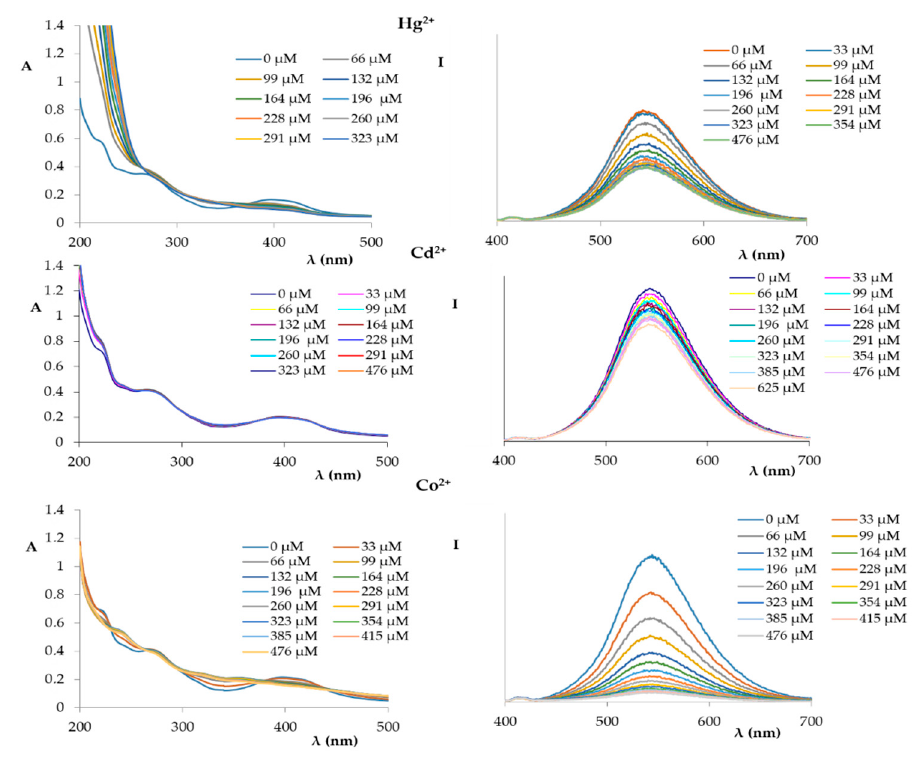
Figure 4. UV spectra ( left ) and fluorescence spectra ( right ) (excitation at 366 nm) of compound 1 (1.72 × 10 − 5 M in EtOH:phosphate buffer) titrated with an increasing amount of Hg 2+ , Cd 2+ , and Co 2+ (1.0 × 10 − 2 M in phosphate buffer).